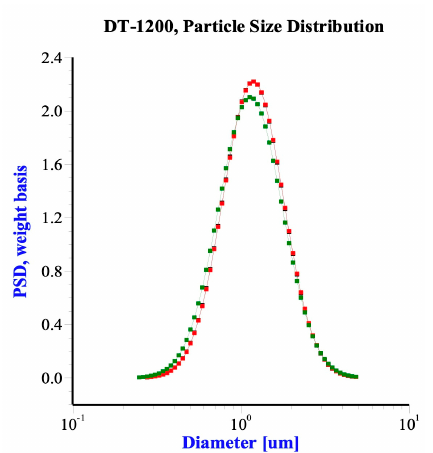
Figure 2. Size distribution of the silica measured by ultrasonic attenuation spectroscopy (Colour difference means repetition).